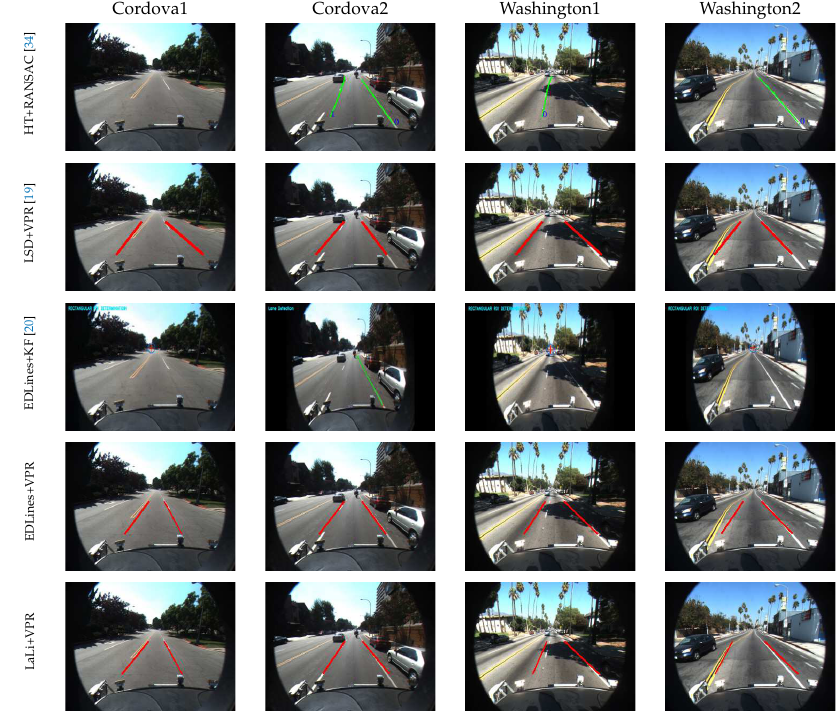
Figure 10. Sample lane detection results on Caltech dataset